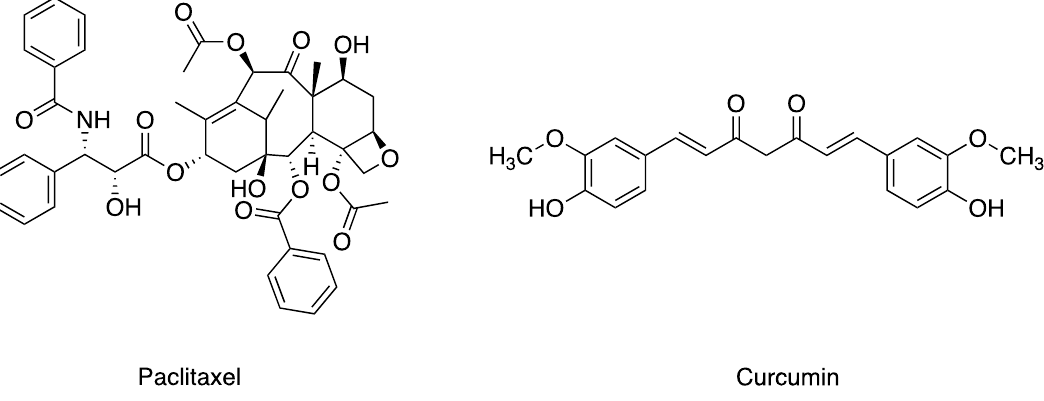
Figure 1. Chemical structures of PTX and CUR. PTX and CUR stand for paclitaxel and curcumin.